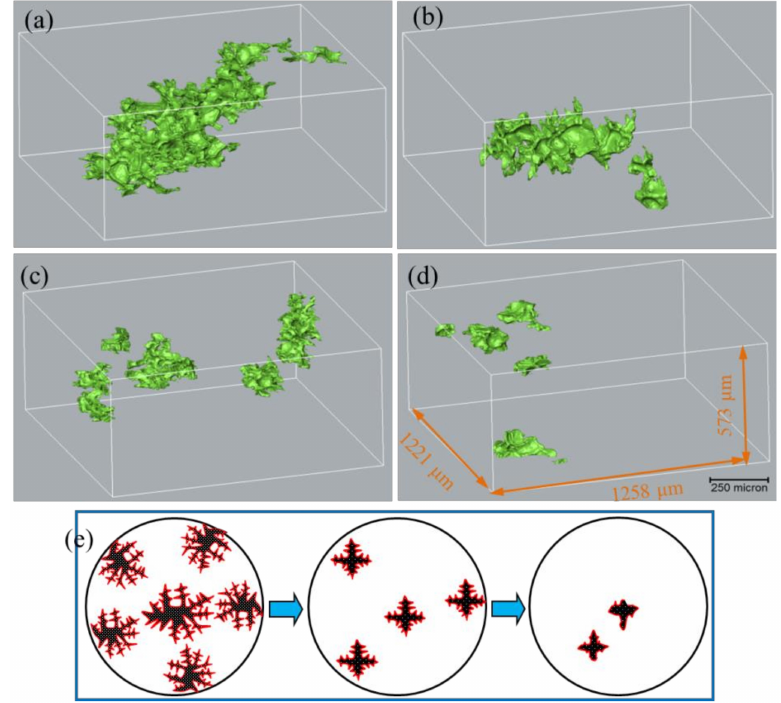
Figure 3. The 3D morphology of the micro-pores in the Al-Cu alloys under TMF with a magnetic flux density of ( a ) 0 mT ( b ) 24 mT ( c ) 32 mT ( d ) 48 mT. ( e ) is the schematic showing the effect of TMF on the distribution and morphology of the